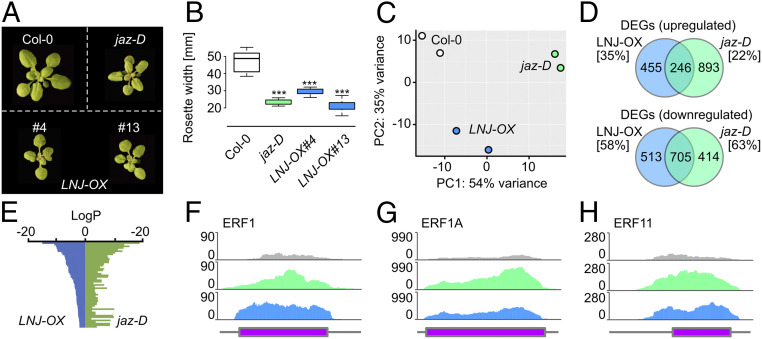
Ectopic expression of the Arabidopsis LNJ protein changes plant size and transgenic plants resemble jaz-D mutant plants. (A) Picture of representative 20-d-old seedlings. (B) Rosette width of wild-type Col-0, jaz-D, and two LNJ-OX transgenic plants. Box plots show the observed experimental data. Rosette width was determined after the transition to flowering. ***P < 0.0005 determined by Student’s t test. n = 11 to 13. (C) Principle component analysis (PCA) of the gene expression (regularized logarithm transformed count data) between the different RNA-seq libraries. Plotted is the percentage of variance for each component for each of the two biological samples per genotype. (D) Venn diagram showing the overlap of differentially expressed genes (log2FC > +1 and < −1, BH-adj. P value < 0.01) compared to the Col-0 wild-type. Numbers in brackets depict the overlap between the two datasets. (E) Comparative gene ontology analysis of genes down-regulated in LNJ-OX, and jaz-D shows a large overlap in genes and GO categories enriched in the two genetic backgrounds. (F–H) RNA-seq read coverages of representative candidate genes showing expression levels in the three different backgrounds.